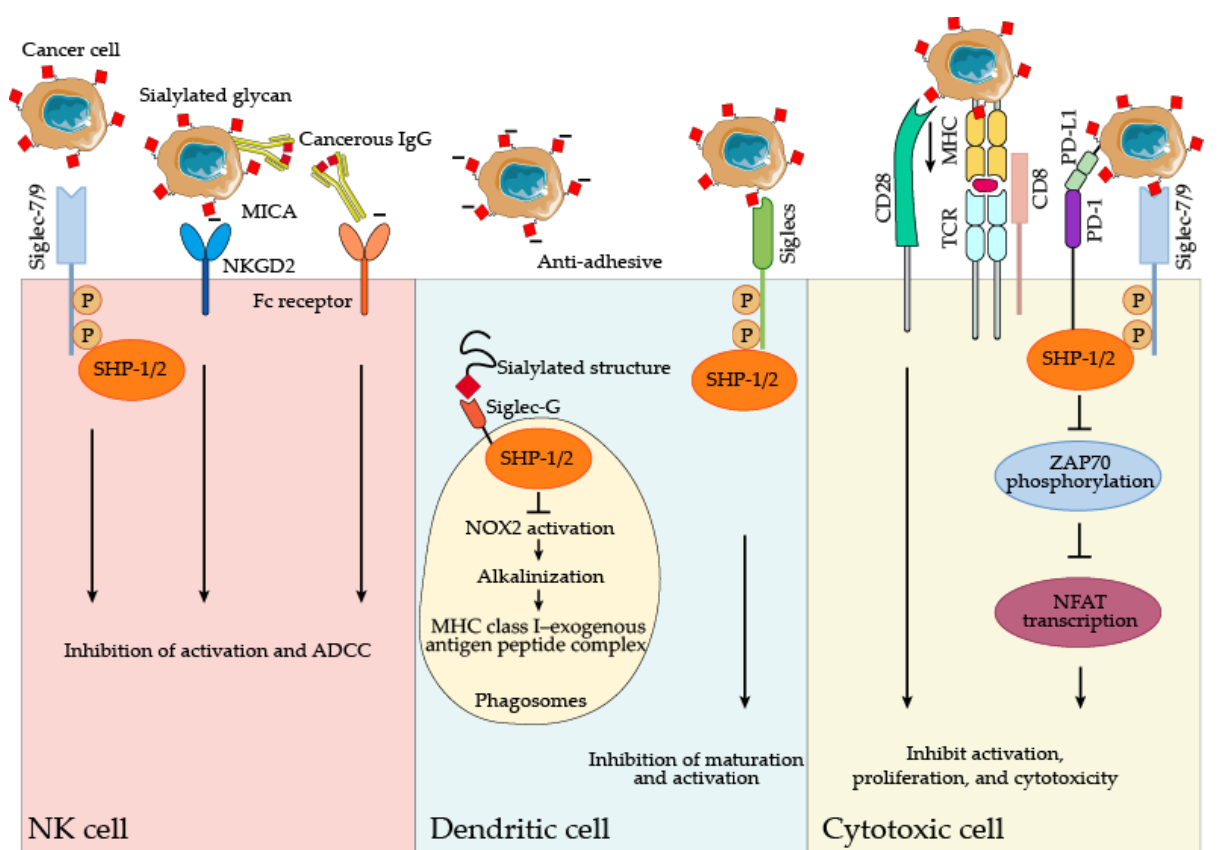
Figure 5. The impact of sialylation on immune cell functions. Siglec: sialic acid-binding immunoglobulin-like lectin; MICA: MHC class I – related chain A; NKGD2: natural-killer group 2, member D; IgG: immunoglobulin G; ADCC: antibody-dependent cell-mediated cytotoxicity; SHP: Src homology region 2 domain-containing phosphatase; MHC: major histocompatibility complex; TCR: T cell receptor; PD-1: programmed death-1; PD-L1: programmed death-ligand 1; ZAP70: zeta chain of T cell receptor associated protein kinase 70; NFAT: nuclear factor of activated T-cells.